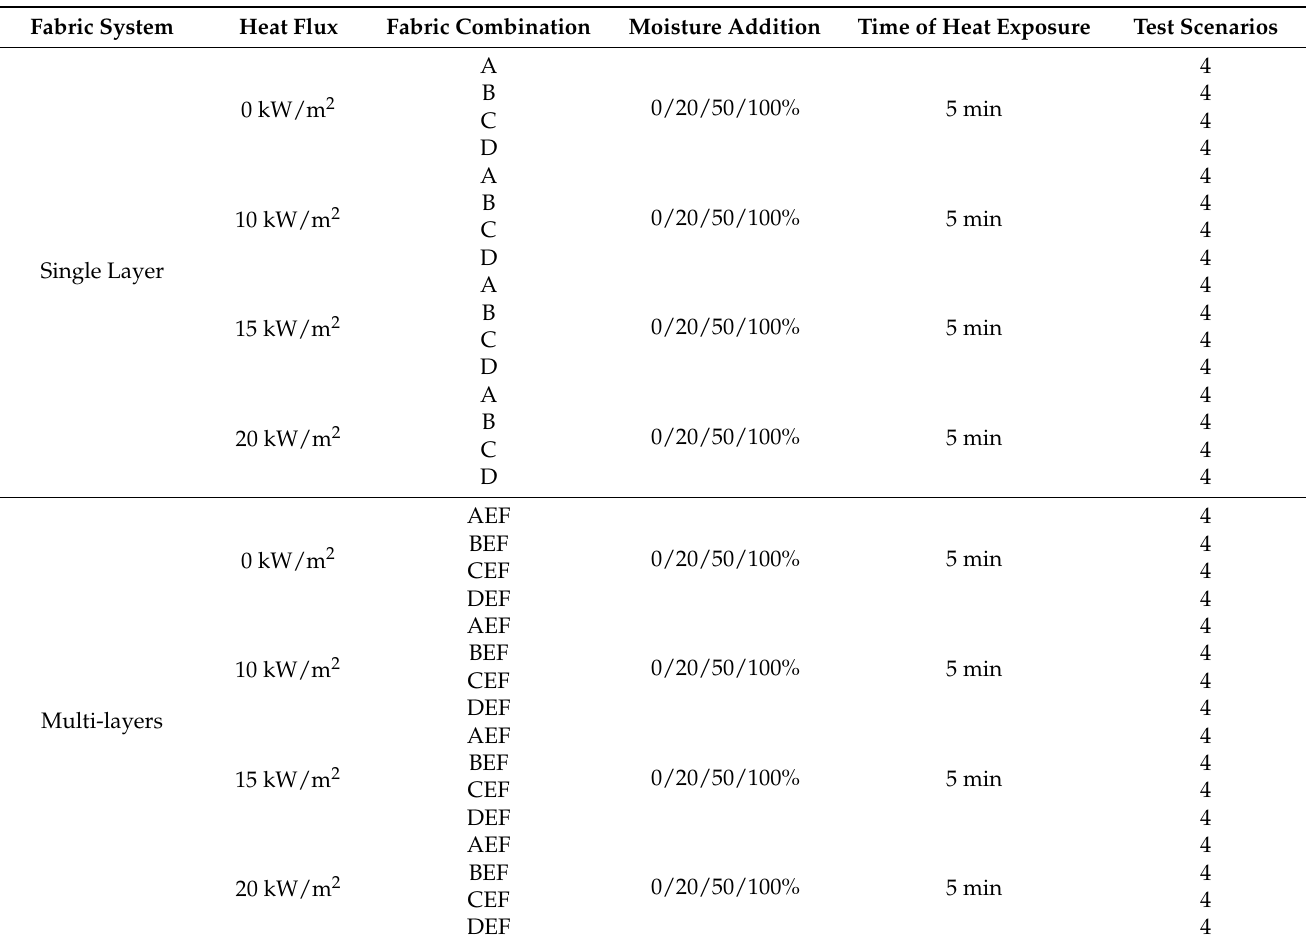
Table 2. Details of test